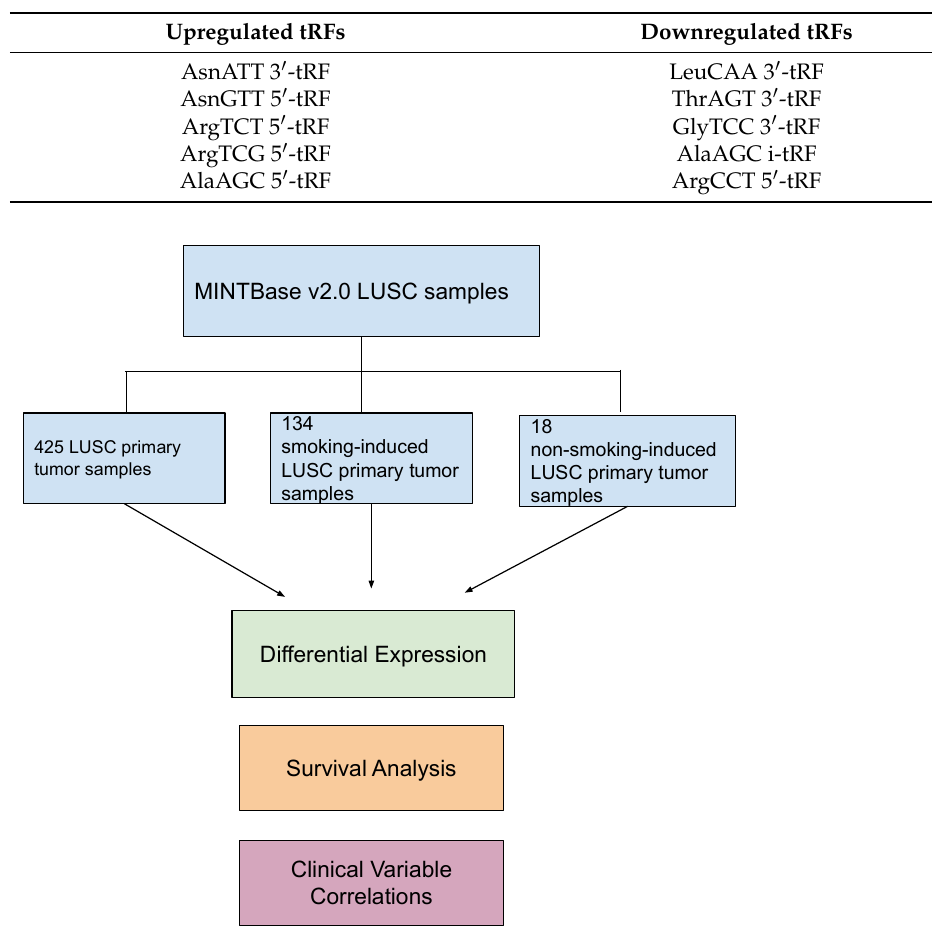
Figure 1. Schematic of project workflow. Transfer RNA-derived fragment (tRF) counts were extracted from MINTbase v2.0 (https://cm.jefferson.edu/tcga-mintmap-profiles/; accessed on 14 December 2022) for 425 lung squamous cell carcinoma (LUSC) primary tumor samples and 36 adjacent normal samples. We analyzed the data in three primary cohorts: (1) primary tumor samples (425 samples), (2) smoking-induced LUSC primary tumor samples (134 samples), and (3) non- smoking-induced LUSC primary tumor samples (18 samples). Adjacent normal LUSC samples were used as the control group. Differential expression analysis was performed to identify significantly differentially expressed tRFs in each of these cohorts (|log fold change (FC)| > 1 and p -value < 0.05). tRF correlations to patient survival outcomes and clinical variables were also performed to analyze the role of these tRFs in cancer onset and development ( p- value < 0.05). We next analyzed the correlations between tRF expression and patient survival outcomes using Kaplan–Meier survival analysis and plotted the results using Cox proportional hazards regression, with a p- value of 0.05 indicating a significant result. We found that 10 tRFs were significantly correlated to patient survival outcomes. Specifically, the upregulation of AlaCGC 5′-tRF was associated with worse patient survival outcomes, while the downregulation of TyrGTA i-tRF, GlyGCC i-tRF, LeuAAG 3′-tRF, LysTTT 5′- half, CysGCA 5′-tRF, TrpTCA 3′-tRF, ArgTCG 5′-tRF, and LeuTAA i’-tRF was associated with worse patient survival outcomes (Figure 2). Notably, ArgTCG 5′-tRF was both significantly differentially expressed in tumor samples and implicated in worse patient survival outcomes, suggesting its potential to act as a biomarker of worse clinical outcomes in LUSC (Figure 2). However, further studies are required to fully elucidate this finding.